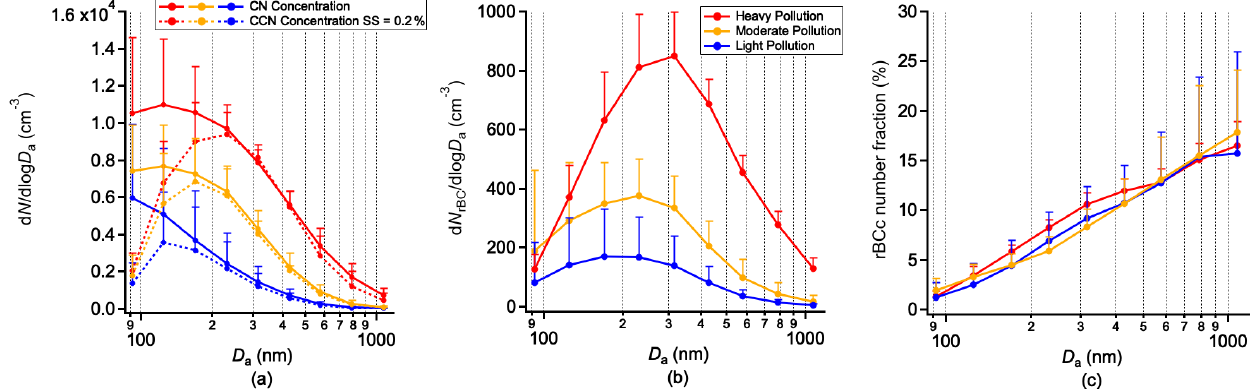
Figure 7. Size-resolved (a) CN and CCN at SS = 0 . 2% number concentrations, (b) rBC number concentration and (c) number fraction of